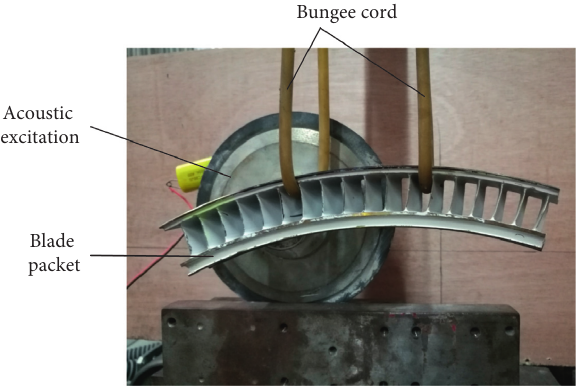
Figure 2: The experimental scheme.